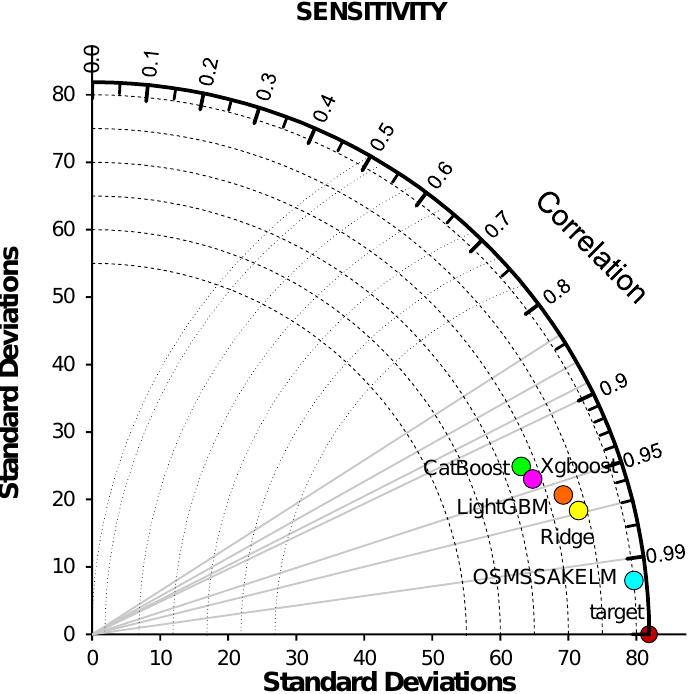
Figure 23. Taylor plot of the proposed model versus other regression methods for the testing phase. Finally, the predicted time series of the models for the test stage are shown in Figure 24. The plots show that the error was minimal, and the fitting was the best compared to the other prediction